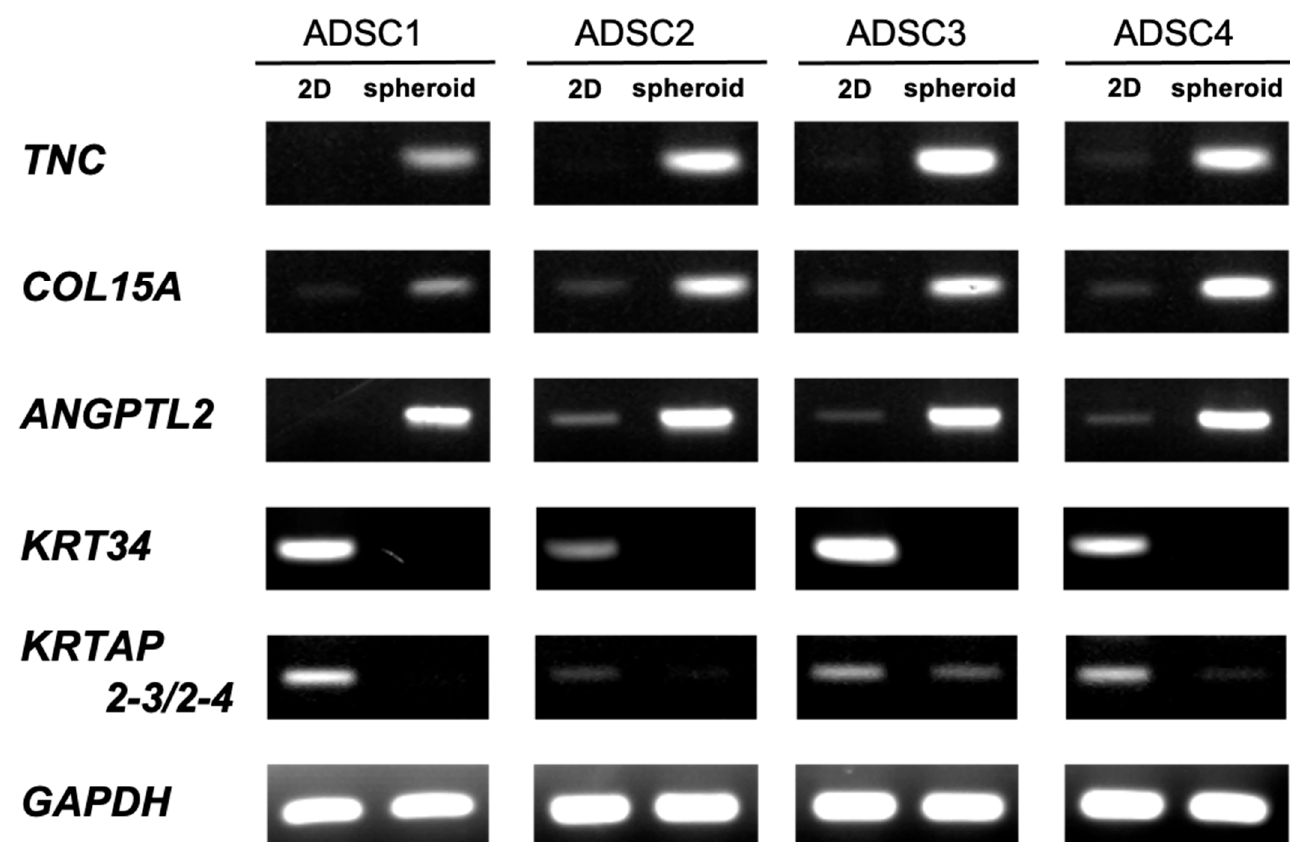
Figure 7. Validation of mRNA expression of screened genes by semi-quantitative RT–PCR for AD-SCs.